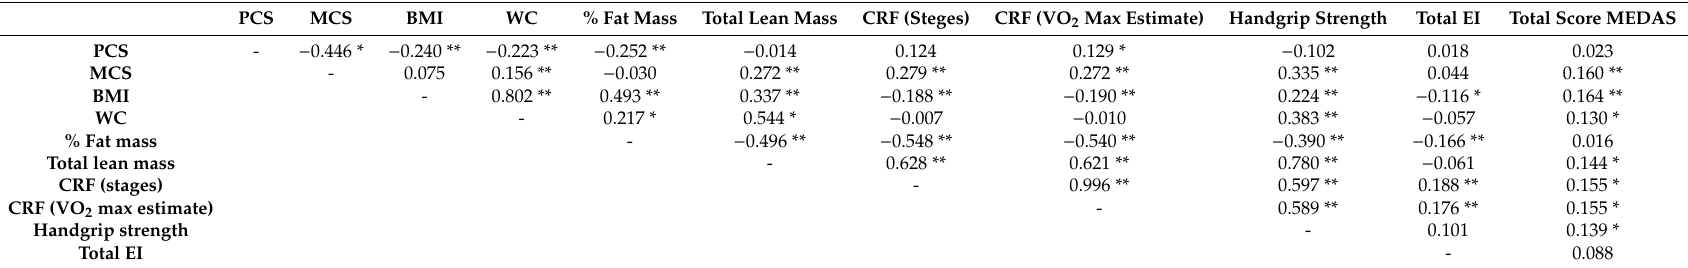
Table 2. Bivariate correlations between health-related quality of life (HRQoL) domains with body composition, cardiorespiratory fitness (CRF), muscle strength, physical activity (PA), total energy intake (EI), and total Mediterranean Diet Adherence Screener (MEDAS-14) score.